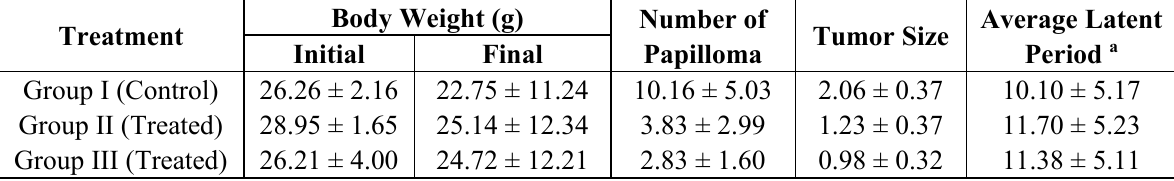
Table 1. Chemopreventive effect of rutin against DMBA croton oil induced skin carcinogenesis in mice.